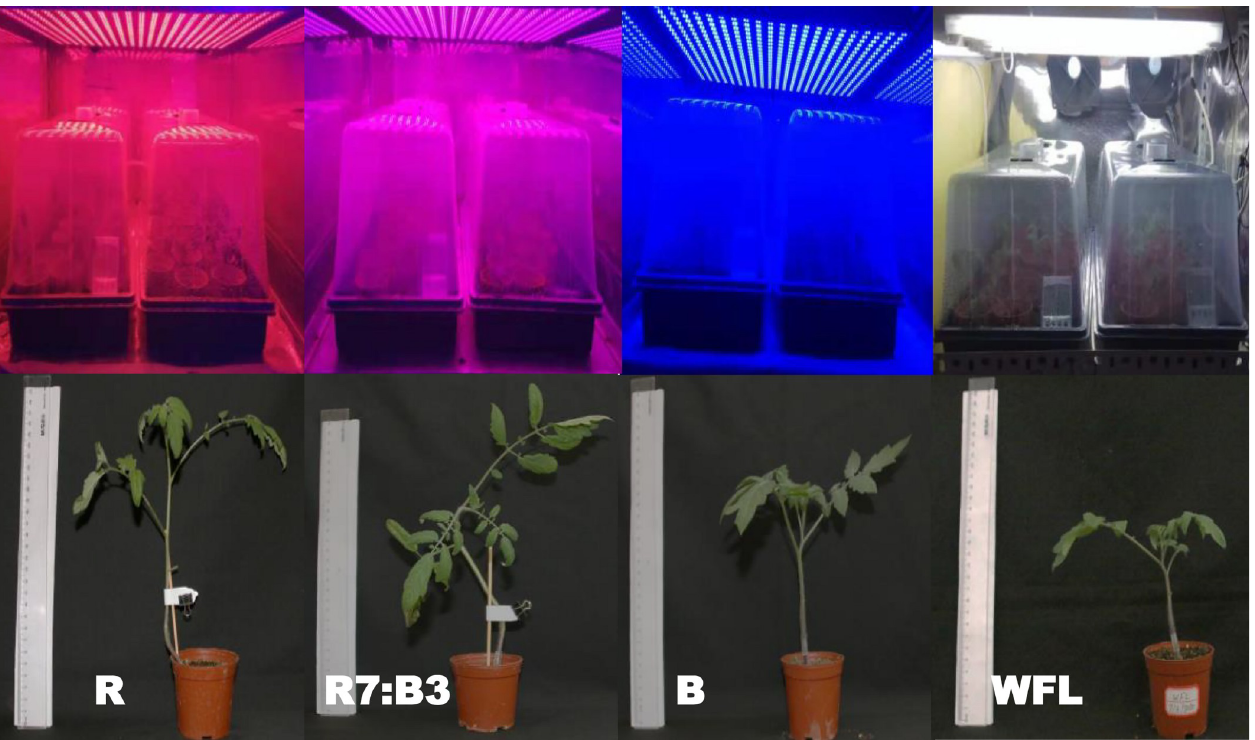
Fig 2. Effect of the LED light on plant morphology of tomato grafted grown under (R = Red light 100%, R7:B3 = Red70%+ Blue30%, B = Blue light 100%, WFL = White Fluorescent Lamps100%) during 20 days after the grafting process.